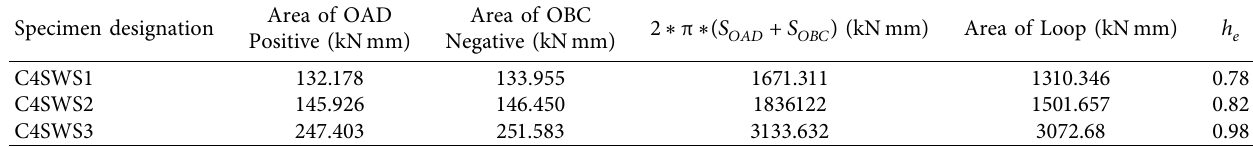
Table 8: Cumulative energy dissipation and viscous damping ratio of 150 ° -type connection.